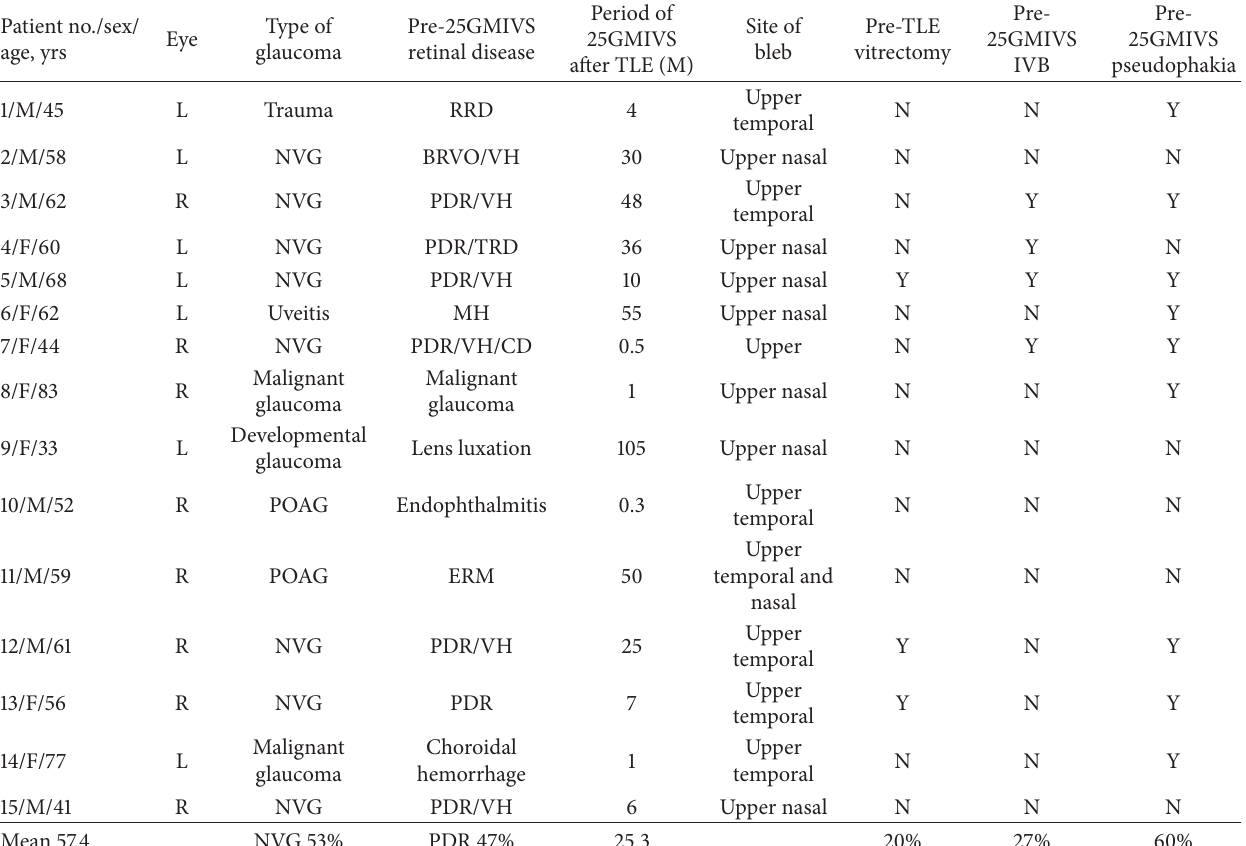
Table 1: Characteristics and pre-25-gauge microincision vitrectomy course of 15 glaucomatous eyes. Patient